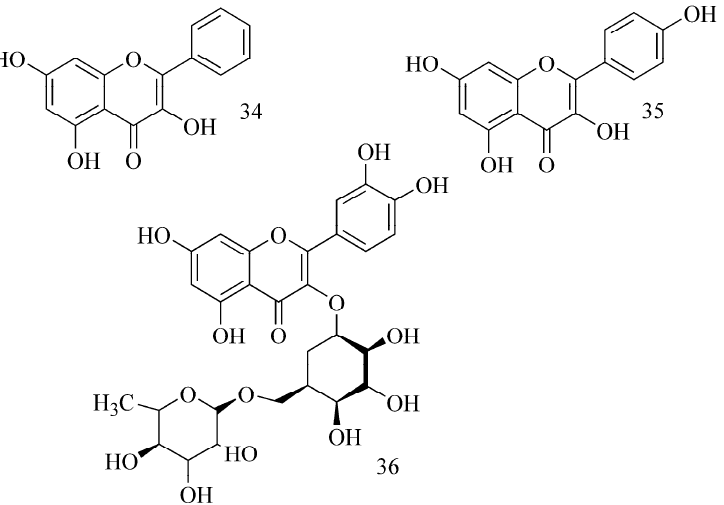
Figure 12. Chemical structures of galangin ( 34 ), kaempferol ( 35 ) and rutin ( 36